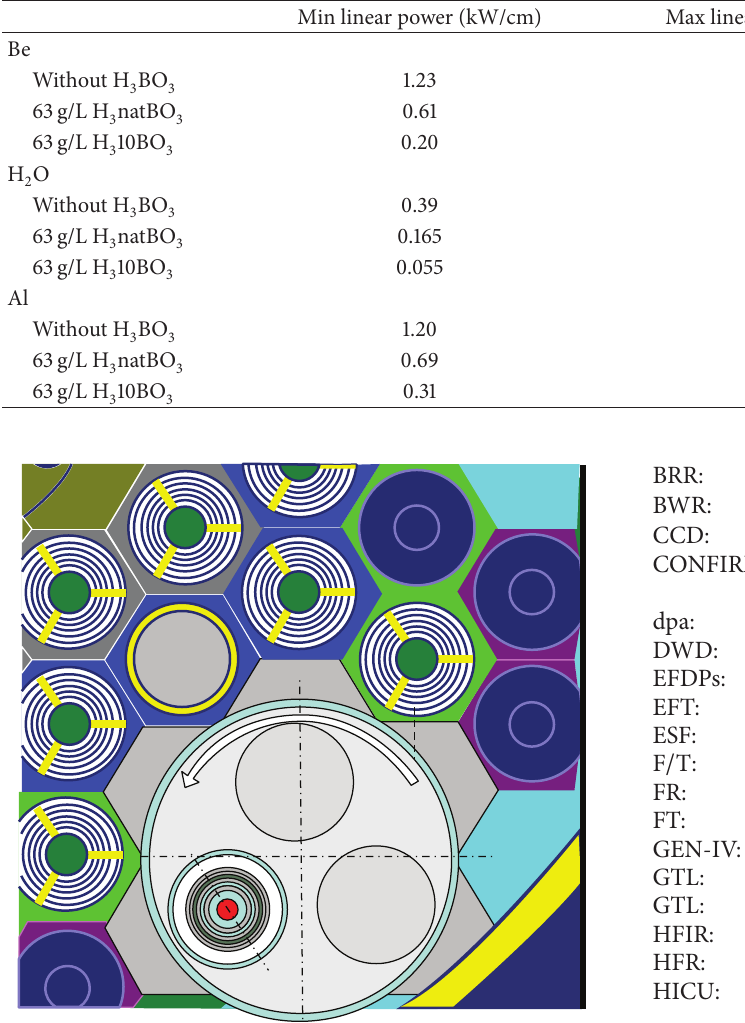
Table 7: Three solutions for the plug material have been evaluated: beryllium, light water, and aluminum [27].